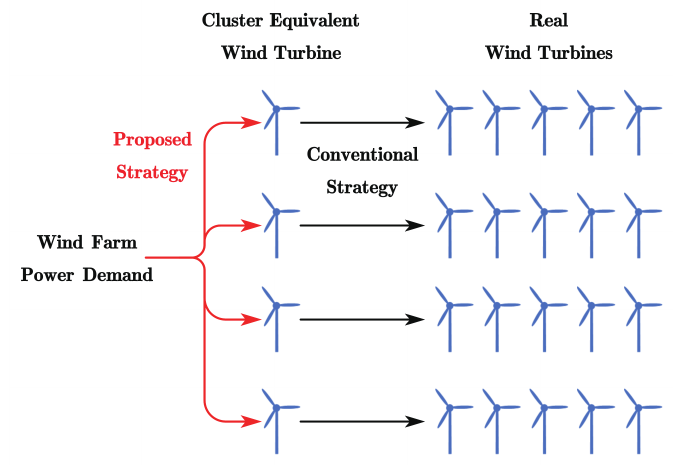
Figure 4. Wind farm control